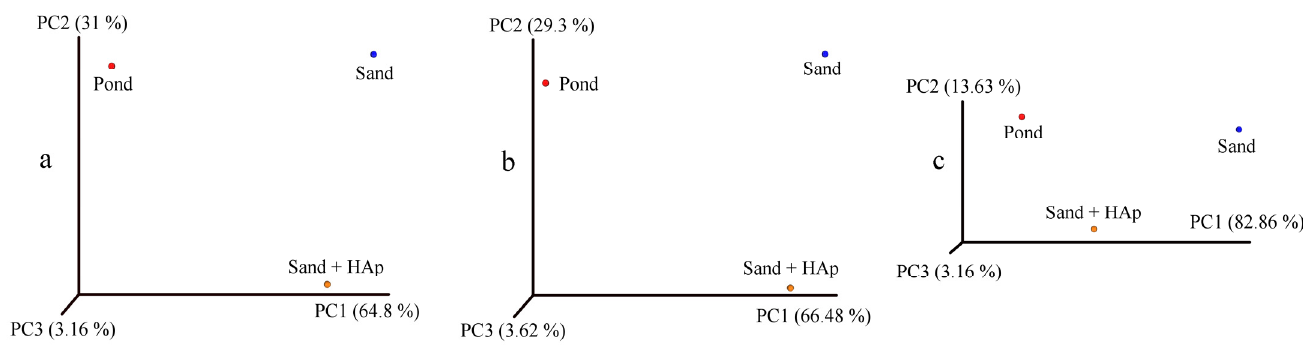
Figure 4. Scatter plots showing the results of the Euclidean principal coordinate analysis (PCA) indicating variance of the microbiome composition at the level of families ( a ), genera ( b ) and species ( c ), before and after the treatment with HAp nanoparticles in comparison with the composition of the soil sampled from a random location, a pond in the Encino area of Los Angeles. Principal com ‐ ponents PC1, PC2 and PC3 ranged from 64.8–82.9%, 13.6–31.0%, and 3.2–3.6%, respectively.